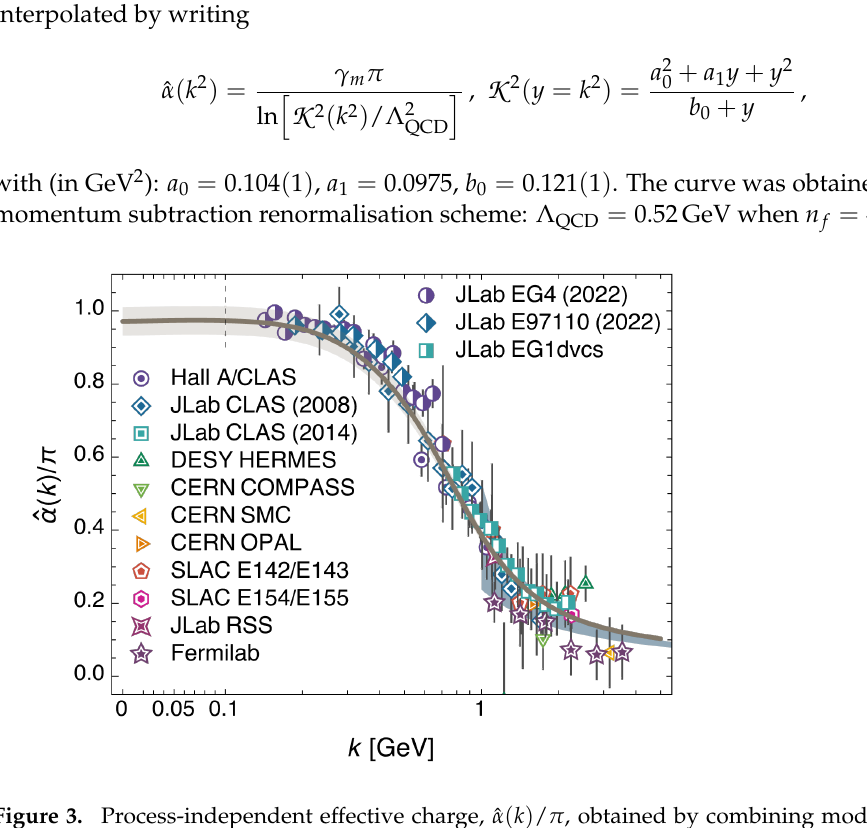
Figure 3. Process-independent effective charge, ˆ α ( k ) / π , obtained by combining modern results from continuum and lattice analyses of QCD’s gauge sector [71]. Existing data on the process- dependent charge α g [94,95], defined via the Bjorken sum rule, is shown for comparison—see 1 References[95–121]. (Image courtesy of